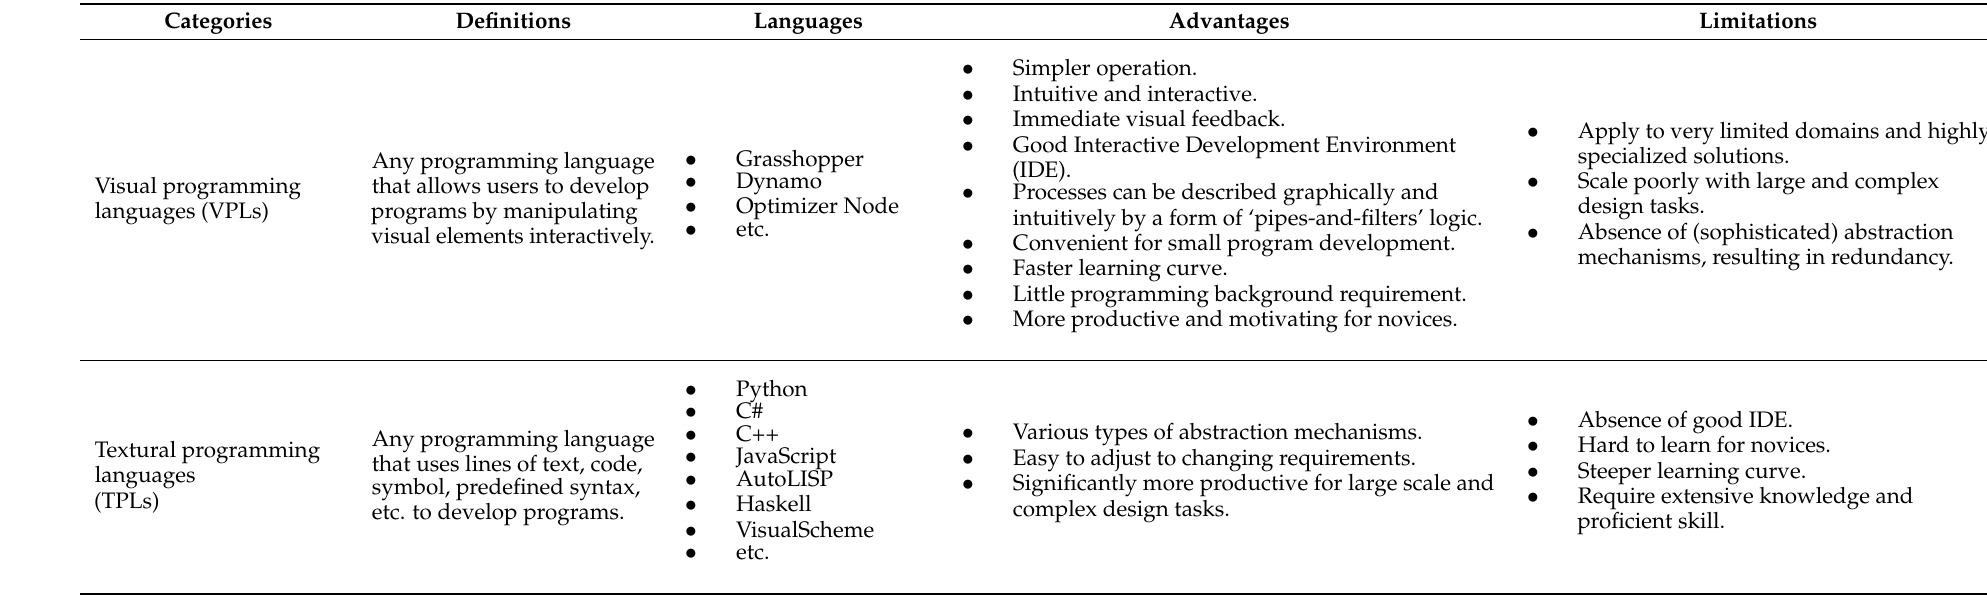
Table 3. Comparison between VPLs and TPLs regarding definitions, languages, advantages, and limitations.